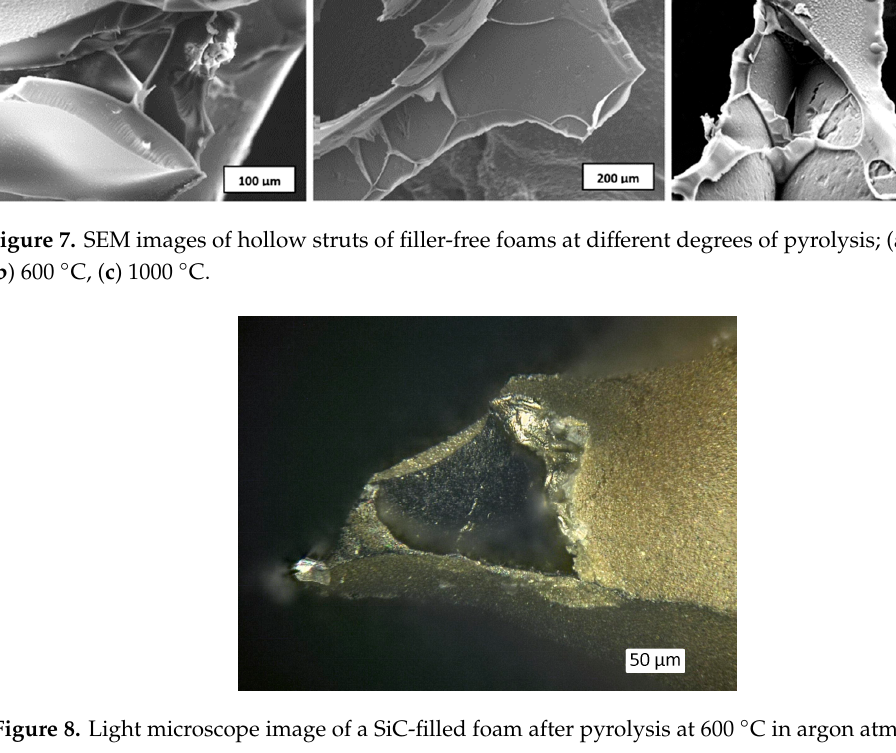
Figure 8. Light microscope image of a SiC-filled foam after pyrolysis at 600 °C in argon atmosphere.